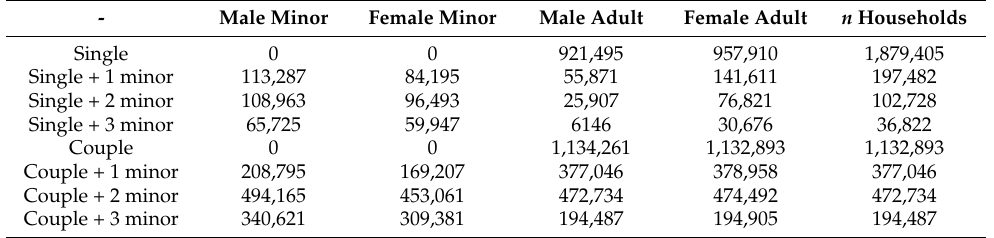
Table 2. Number of persons and households in Sweden (excepts those listed in the ‘other’ category). -